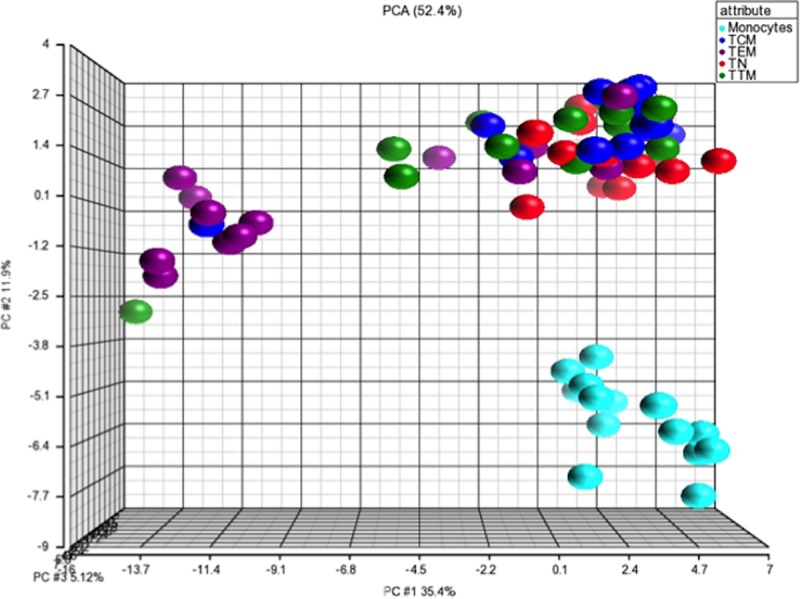
Transcriptomic analysis: A broad multiplex transcriptional profiling analysis of 96 genes was performed in monocytes (CD3-CD4-CD14+) and resting CD4 T-cells subsets: Naive (TN; CD45RA+CCR7+CD27+) central-memory (TCM; CD45RA-CCR7+CD27+) transitional memory (TTM; CD45RA-CCR7-CD27+) and effector-memory cells (TEM; CD45RA-CCR7-CD27-) from 14 HIV-2 infected subjects.A principal component analysis (PCA) plot representation of gene expression profile in each population is shown.